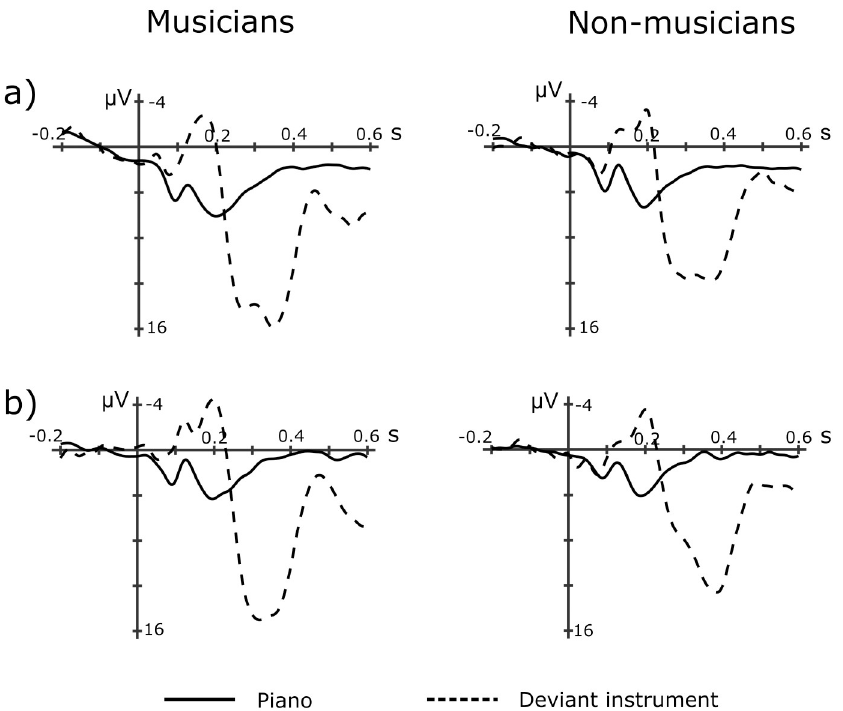
Fig 3. Event-related potentials of deviant instruments. Grand-average ERPs for deviant and standard (piano) instruments for musicians and non-musicians for Experiment 1 (a) and Experiment 2 (b). Potentials at Cz are being